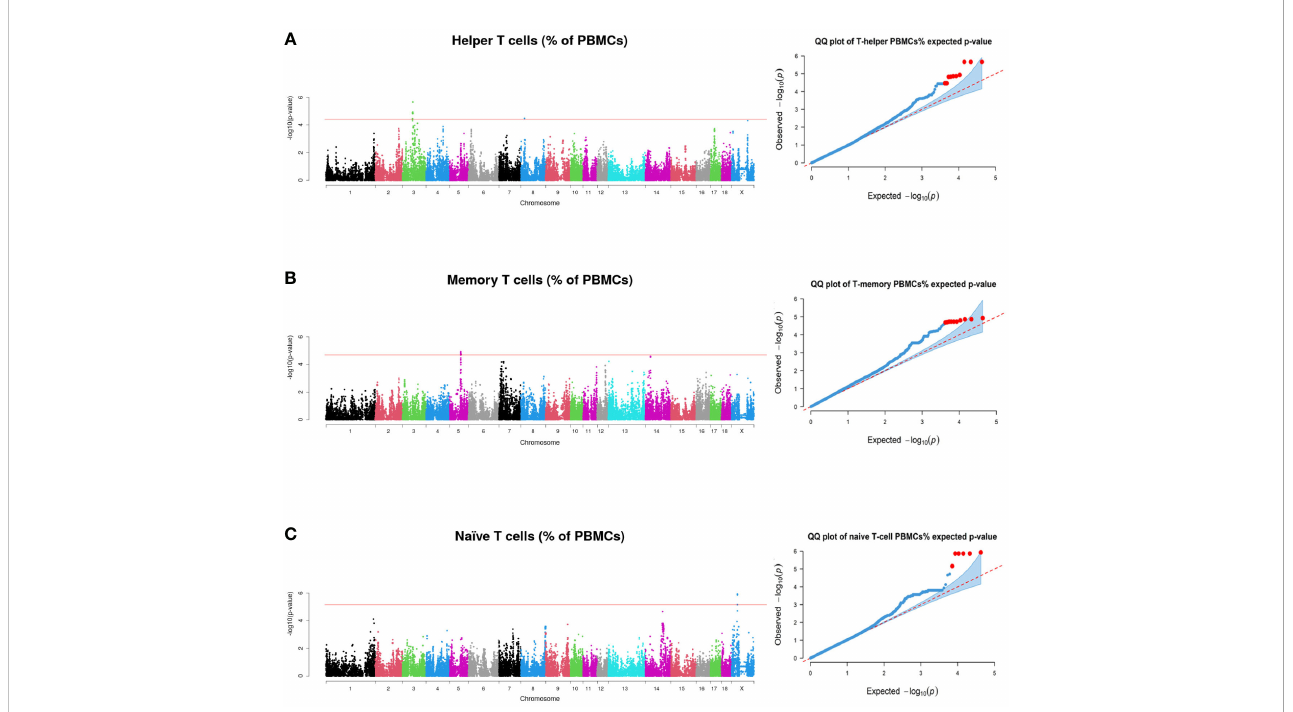
FIGURE 2 Manhattan plots and quantile-quantile plots representing the p-values pro fi les corresponding to the association analysis between immunity traits and SNPs, (A) for Helper T cells (B) for Memory T cells and (C) for Naïve T cells. Red line indicates those SNPs that are below the genome-wide signi fi cance threshold (FDR ≤